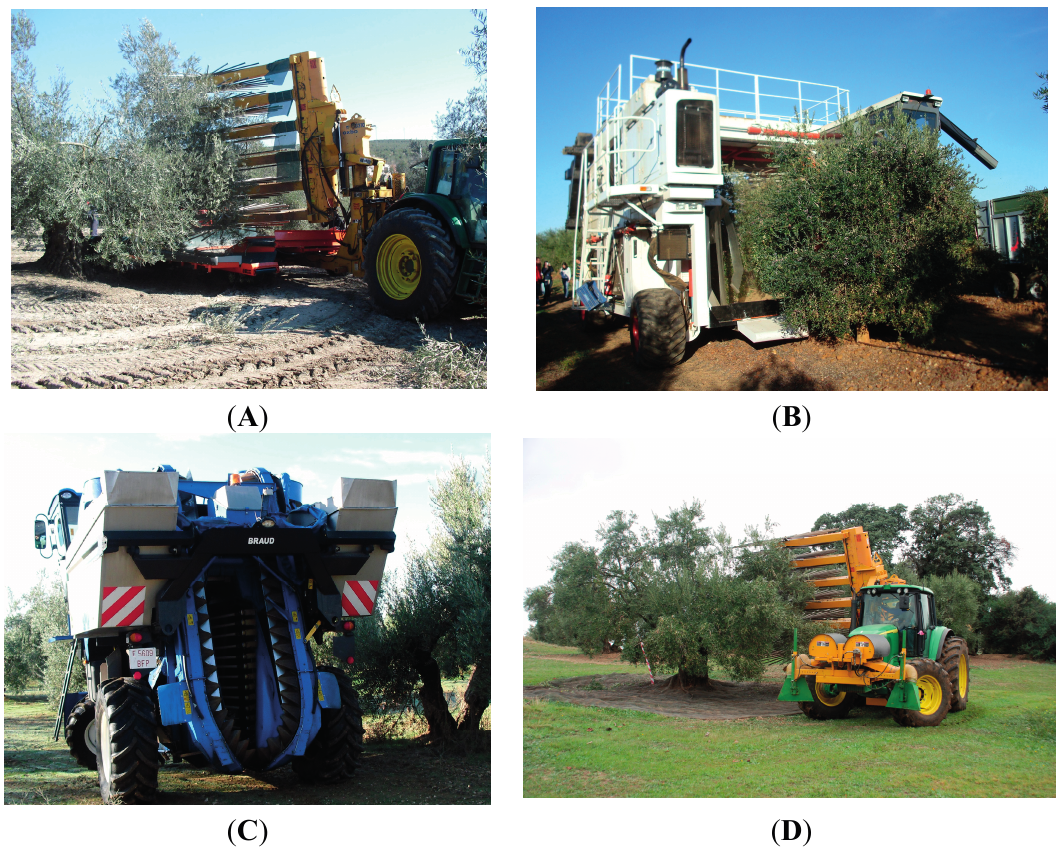
Figure 2. Tracked harvesters: ( A ) Oxbo 3210 with catch frame; ( B ) Maqtec, Colossus; ( C ) New Holland VX 7090 and ( D ) Oxbo 3210 without catch